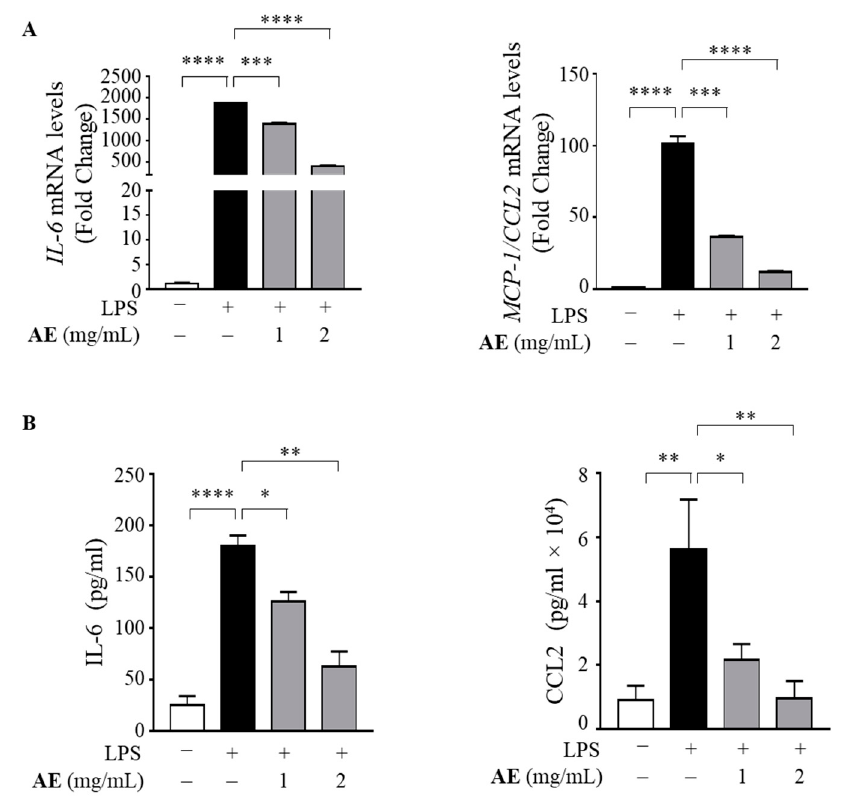
Figure 5. Anti-inflammatory effects of artichoke extract in M1 macrophages. ( A ) Real Time RT-PCR assay for interleukin-6 (IL-6), Monocyte Chemoattractant Protein (MCP)-1/C-C motif chemokine ligand 2 (CCL-2) mRNA expression in human THP-1 derived macrophages untreated ( − ) or treated for 1 h with artichoke extract (AE) at concentrations of 1 and 2 mg/mL and then stimulated with 10 ng/mL of lipopolysaccharides (LPS) for 24 h. ( B ) Enzyme-linked immunosorbent assay (ELISA) for IL-6 and CCL-2 in human THP-1 derived macrophages untreated ( − ) or treated as in ( A ). The values represent the means ± SEMs of three different experiments, performed in duplicate. * p < 0.05, ** p < 0.005, *** p < 0.001, **** p < 0.0001.